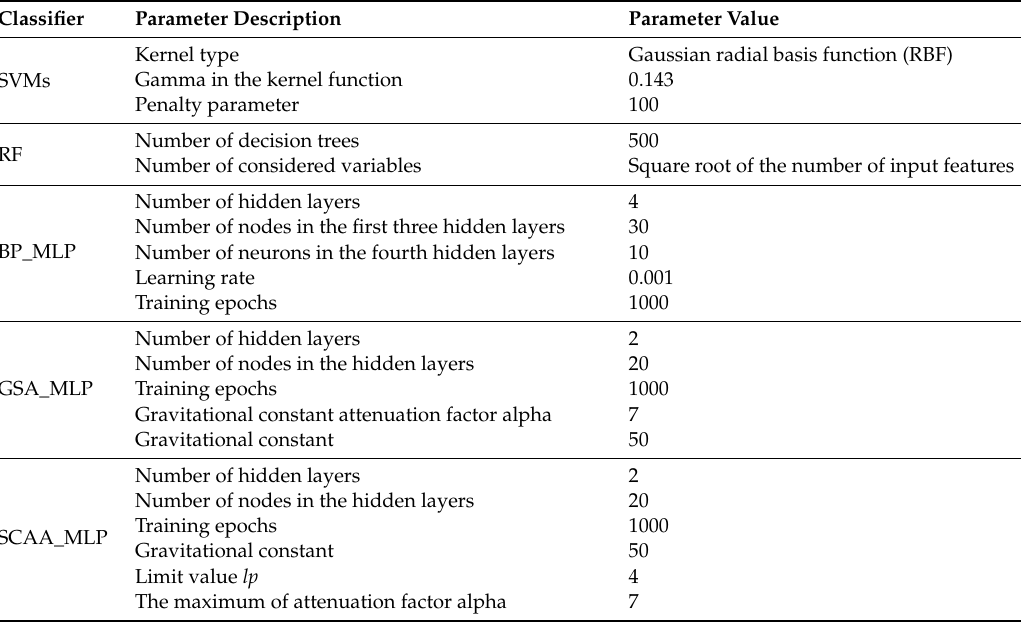
Table 2. Parameter configurations of di ff erent classifiers. SVM—support vector machine; RF—random forest; BP—backpropagation; MLP—multilayer perceptron; GSA—gravitational search algorithm; SCAA—stability-constrained adaptive